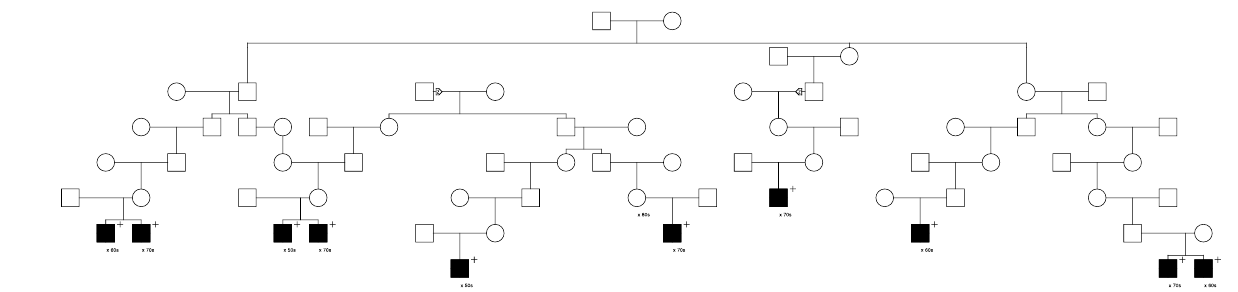
Figure 1. One of the high-risk prostate cancer pedigrees segregating the rare LRBA candidate prostate cancer predisposition variant.